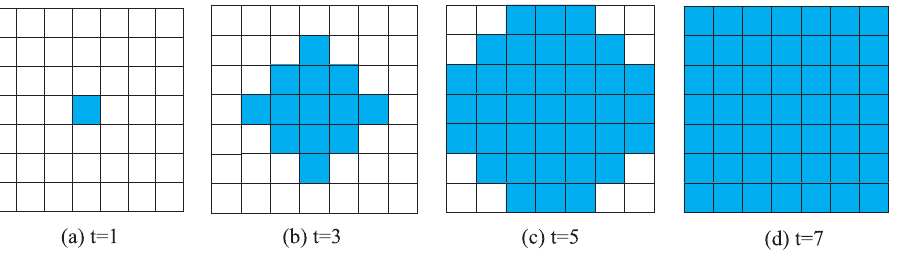
Figure 8. (Color online) Time evolution of defector-invasion on a 7 | 7 square lattice with 4-player neighborhood. Initially, there is only one defector (the green square in figure (a)) and forty-six cooperators (the forty-six blank squares). If R w 2 M = 3 , the defectors invade all the squares in the stationary state ( t ~ 7 , figure(d)).